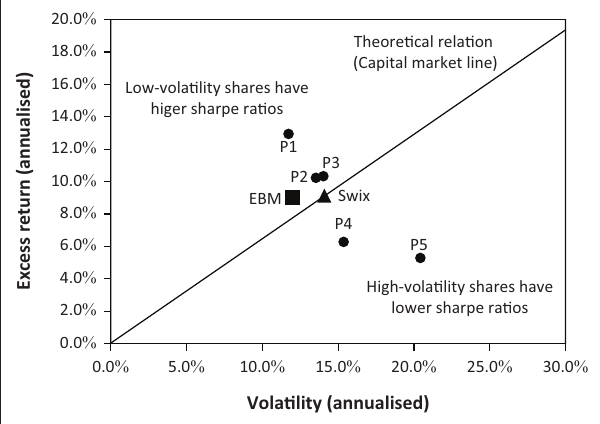
FIGURE 3: Volatility sorted portfolios and the capital market line.